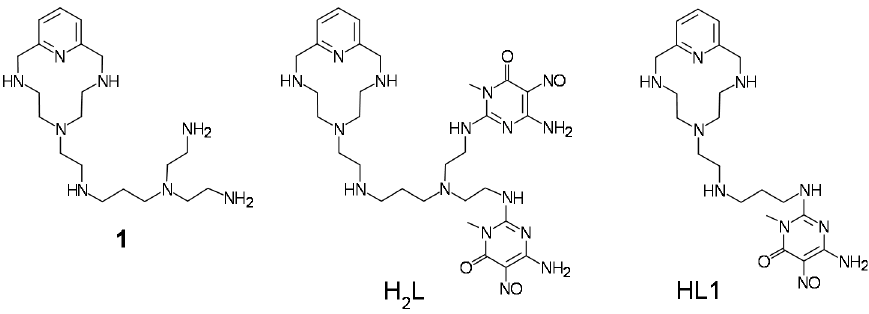
Figure 2. The ligand H 2 L studied in this work, its precursor 1 and the previous HL1 analogue.